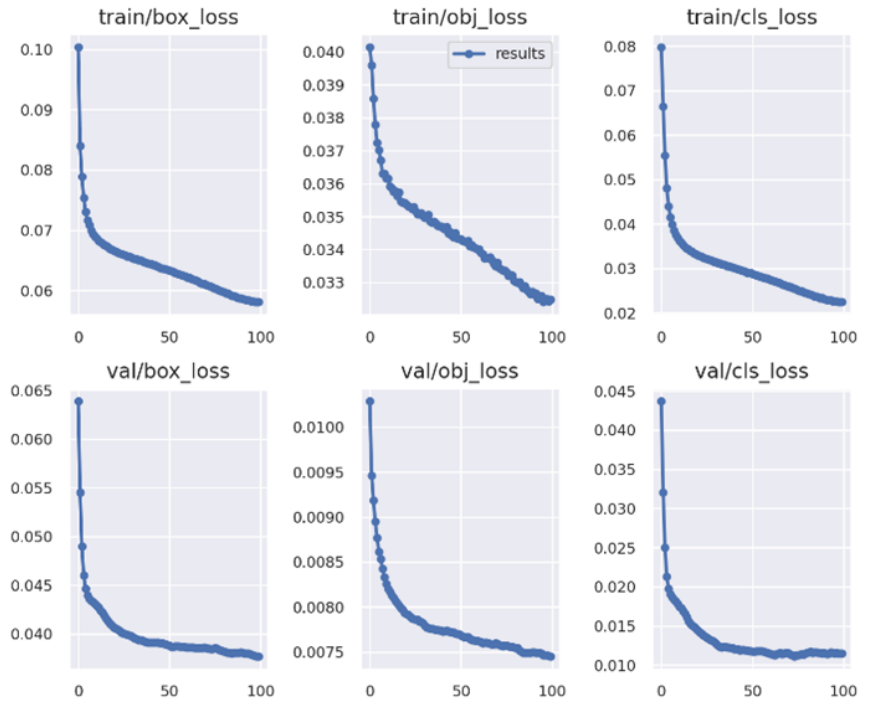
Figure 17. Training on the SEAGULL and COCO combination—progress of metrics during the 100 epochs.